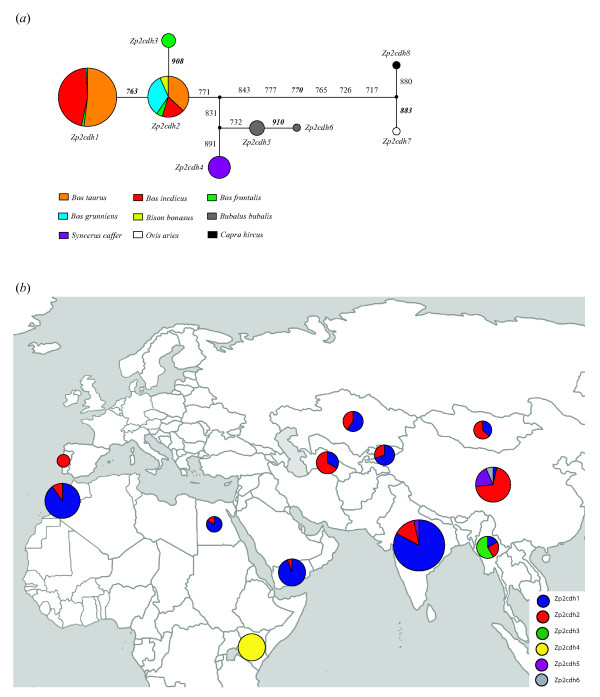
The median-joining network (a) and geographic distribution (b) of the Zp2 coding haplotypes. Numbering of mutations follows the full coding sequence of the bovine Zp2 gene (from base 1 to 2142). Nonsynonymous mutations are shown in bold and italic. The size of each circle is proportional to its frequency in numbers of chromosomes. The haplotypes Zp2cdh7 and Zp2cdh8 from the outgroup species are not shown in the geographic map.